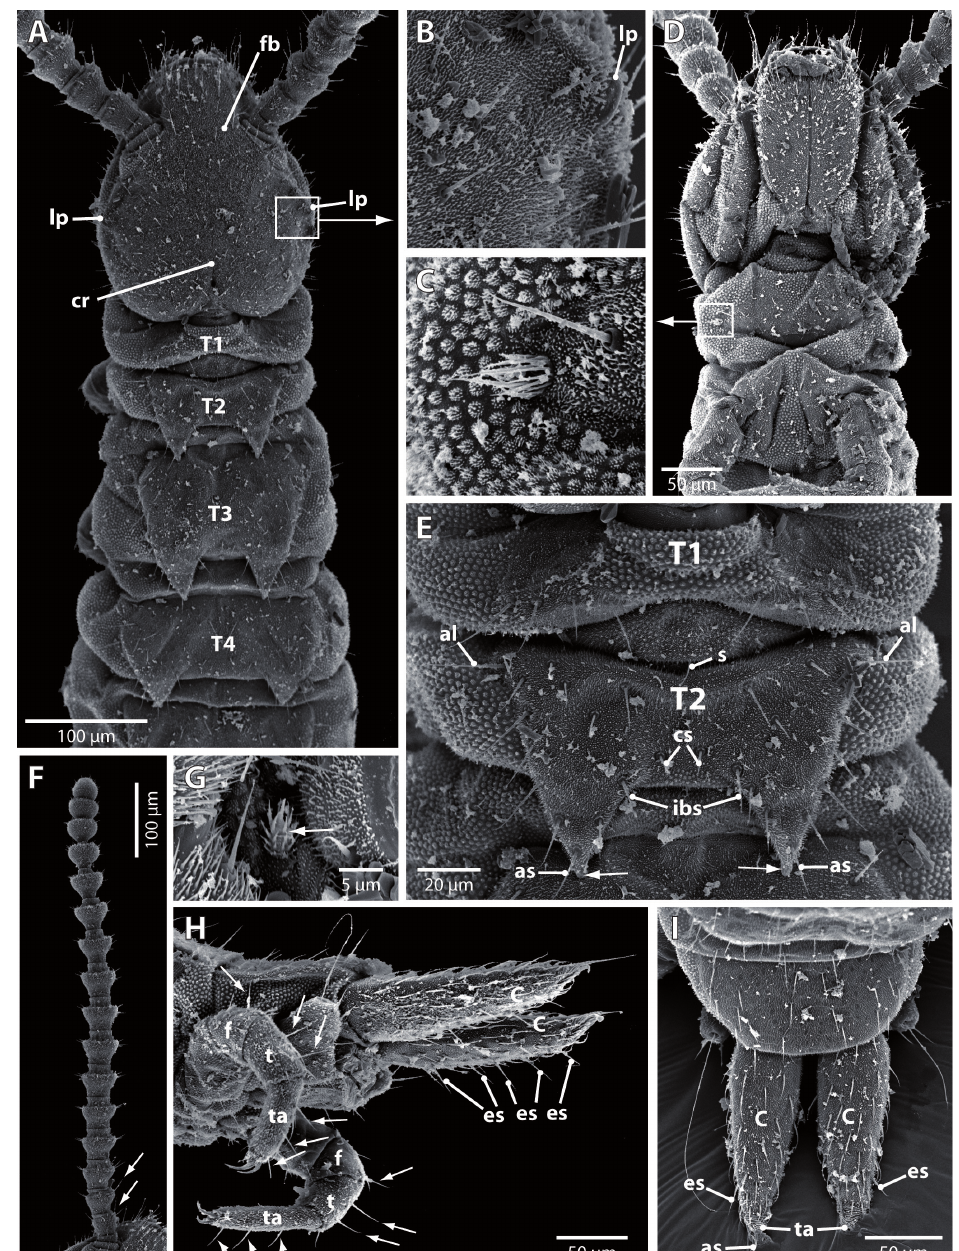
Fig. 6. Symphylella tanganyika sp. nov., holotype (dorsal views) and paratype (ventral and lateral views). A . Head and first 4 tergites ( T1, T2, T3, T4 ), dorsal view. Cr , central rod; fb , frontal branches; lp , lateral protuberances of the head. B . Detail of the surface of the head and lateral protuberance ( lp ). C . Detail of the first leg. D . Head and first 2 pairs of legs, ventral view. E . Detail of first ( T1 ) and second ( T2 ) tergites. Arrows , small end-swelling of triangular processes; al , anterolateral setae; as , apical setae; cs , central seta of the posteromarginal setae; ibs , inner basal setae of the posteromarginal setae; s , seta between first and second tergites. F . Left antenna. Arrows , longer inner setae of the second and third segments. G . Stylus of the leg 11 ( arrow ). H . Posterior part of the trunk, last pairs of legs and cerci ( C ), lateral view. Arrows , longer setae of the femur ( f ), tibia ( t ) and tarsus ( ta ) of last legs; es , erect setae of ventral side of right cercus. I . Last tergite and cerci ( C ), dorsal view. As , apical setae; es , erect setae of outer side of cerci; ta , terminal